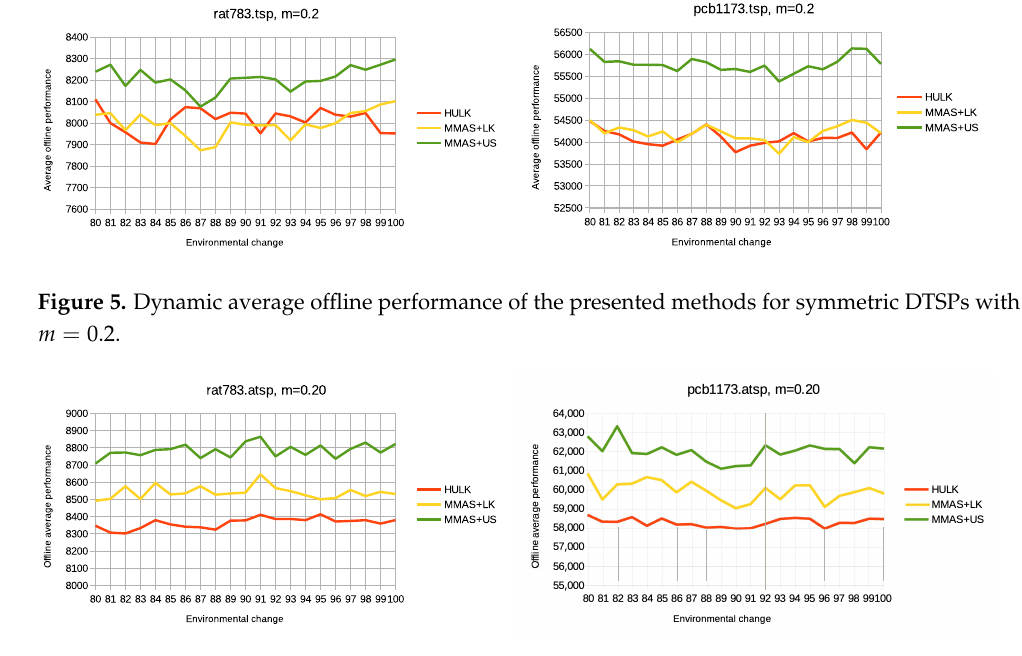
Figure 6. Dynamic average offline performance of the presented methods for asymmetric DTSPs with m =